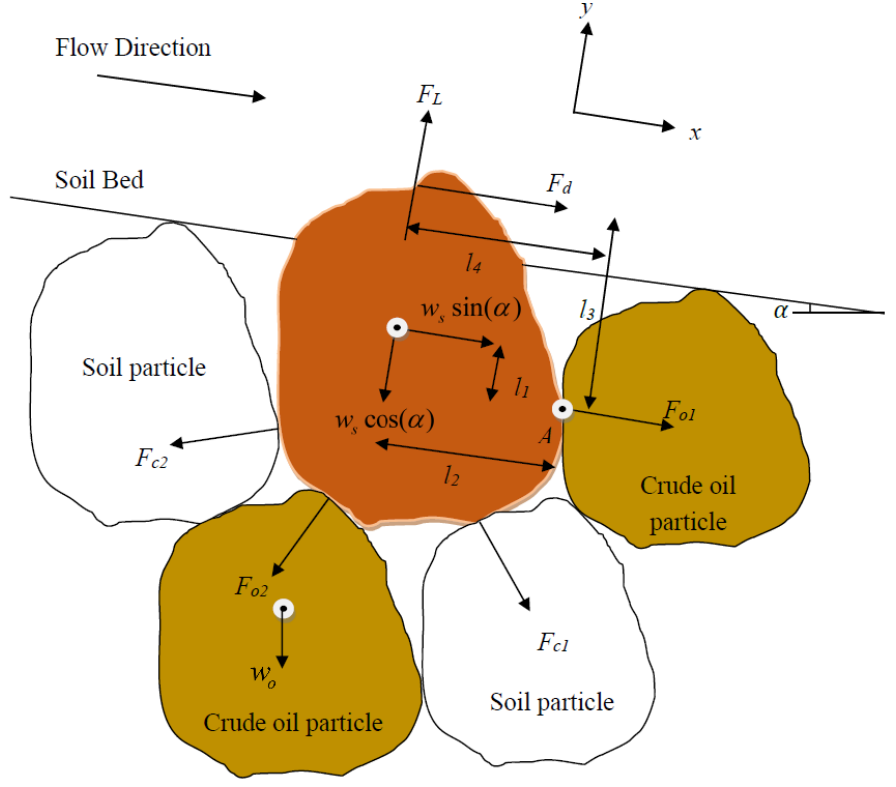
Figure 1. Forces and moment lengths in presence of crude oil particles acting on a single soil particle in JET environmental. Variables are defined in the text.